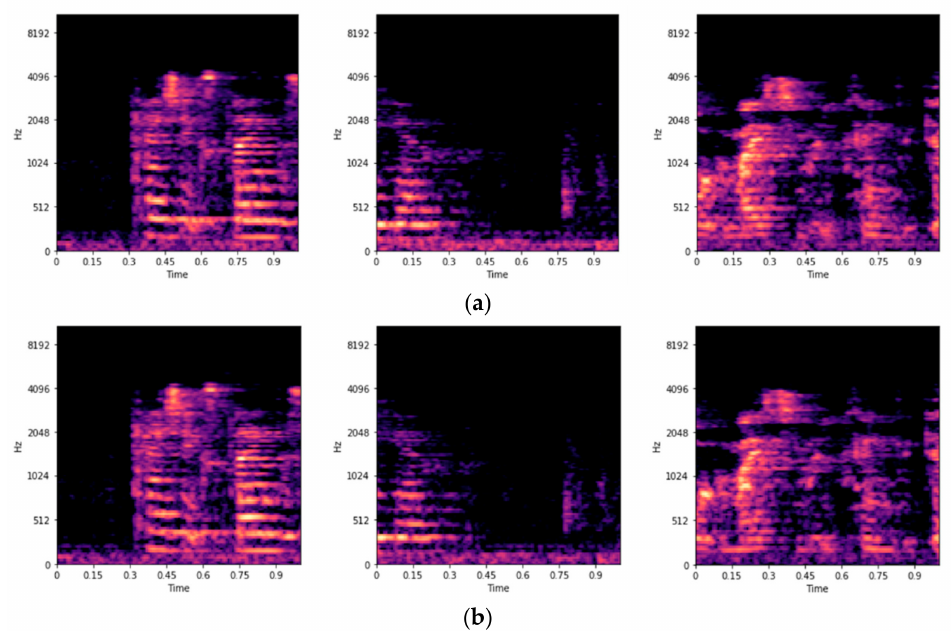
Figure 4. Examples of the log-scaled mel spectrograms extracted from recorded signals. ( a ) Log-scaled mel spectrograms of the first-channel signals; ( b ) Log-scaled mel spectrograms of the second-channel signals.